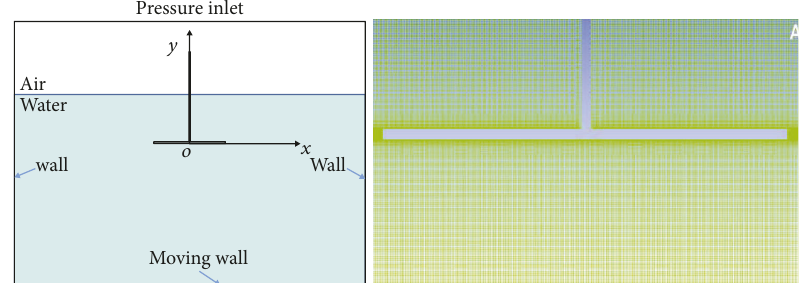
Figure 11: Computational domain and simulation mesh.